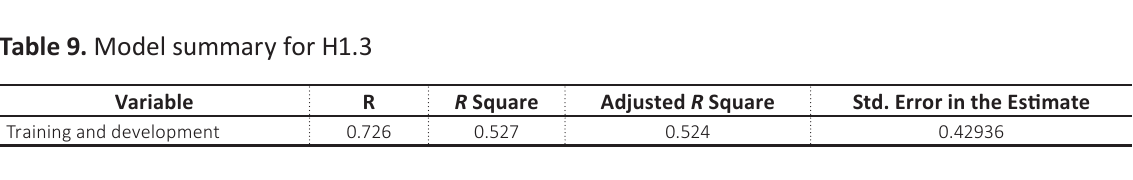
Table 10. Regression coefficients for H1.3